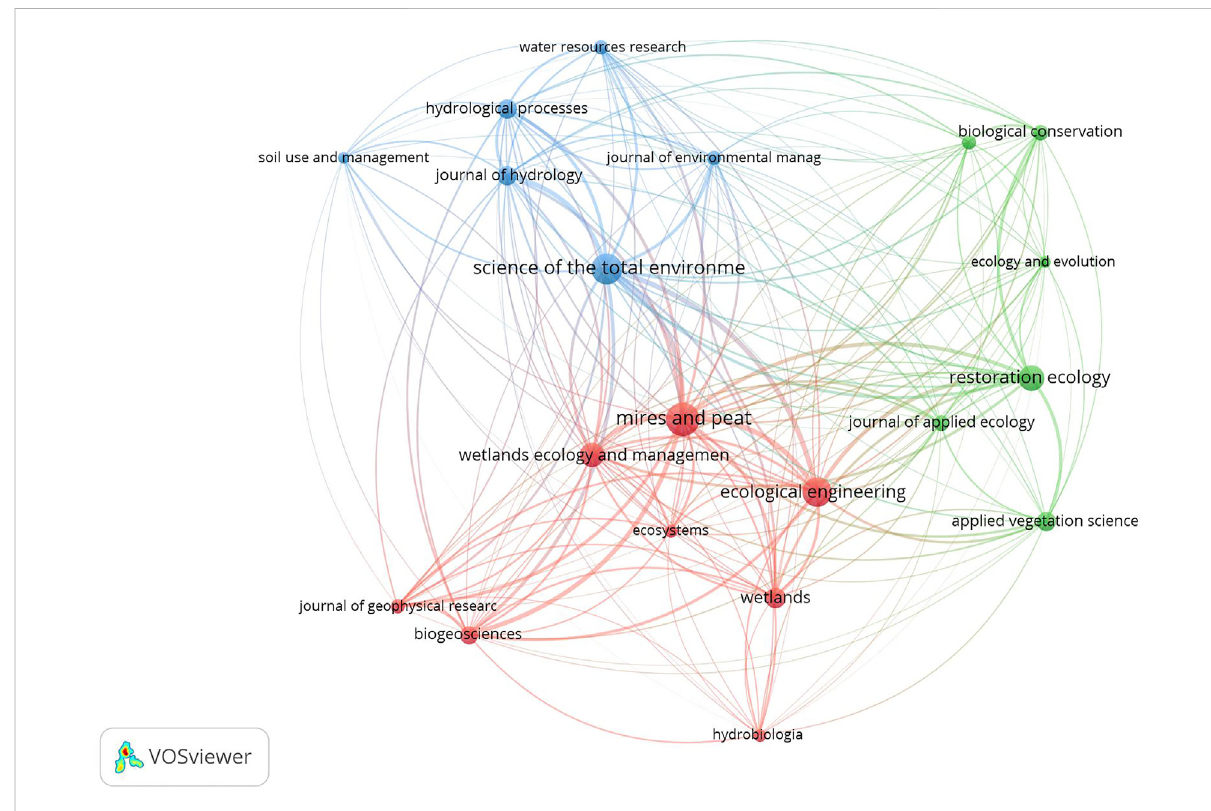
FIGURE 5 Network of the landmark research outlets in the